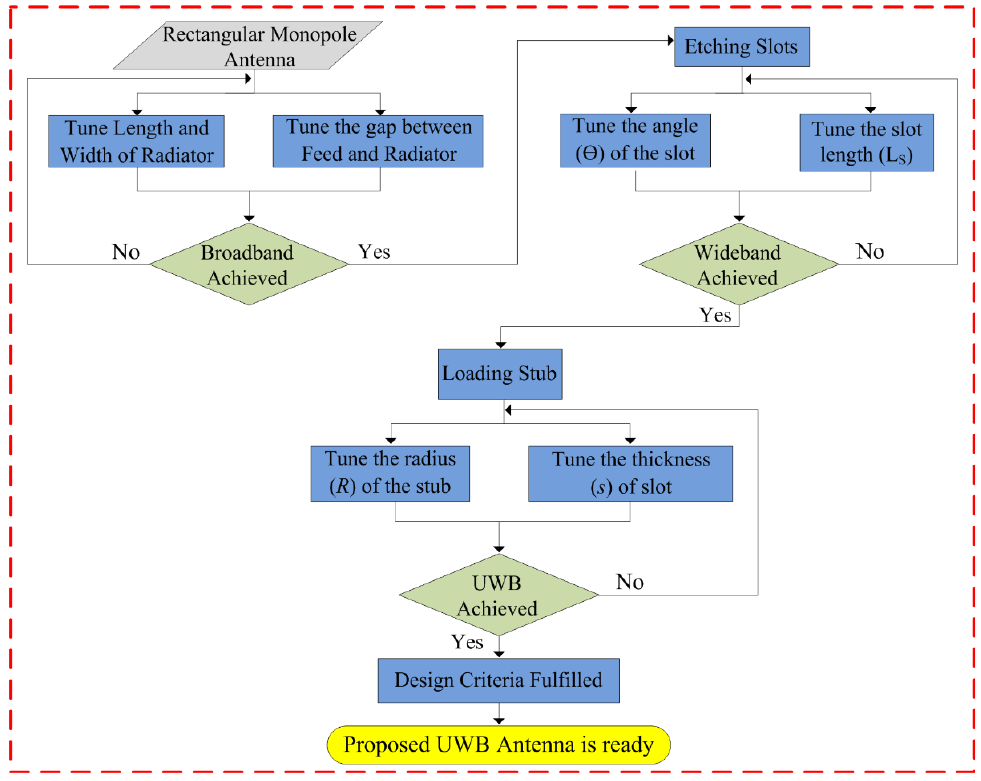
Figure 6. Flow chart explaining the optimization algorithm utilized for the proposed antenna